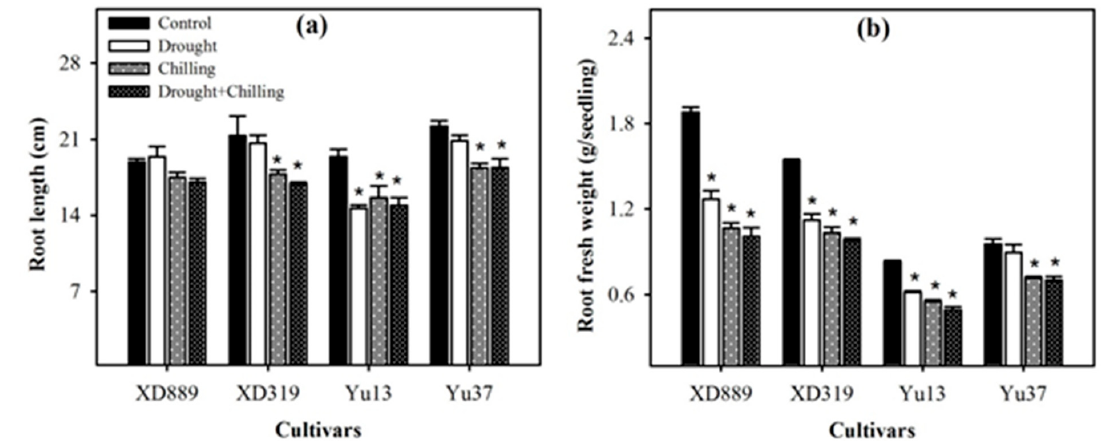
Figure 4. Root length ( a ) and root fresh weight ( b ) of four maize cultivars as influenced by the drought, chilling, and drought + chilling stresses. Vertical bars above mean indicate standard error of three replicates. Mean value for each treatment with * indicate significant differences compared with control according to LSD test ( P ≤ 0.05).